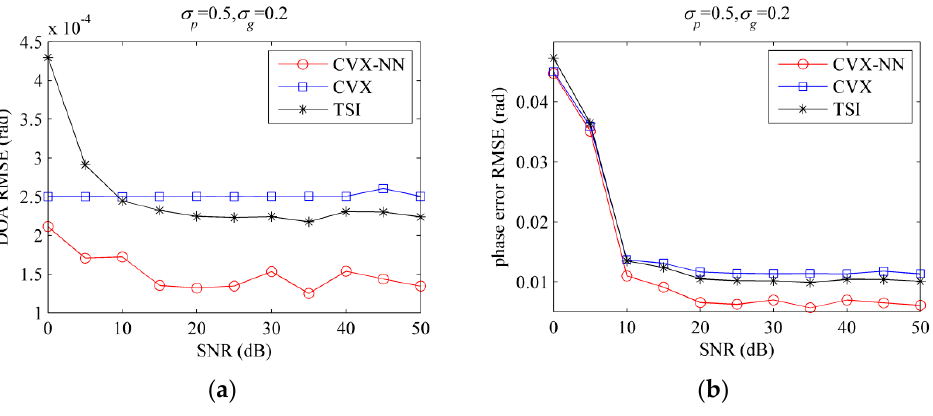
Figure 7. Estimated DOA and phase error RMSE versus SNR: ( a ) DOA; ( b ) phase error.